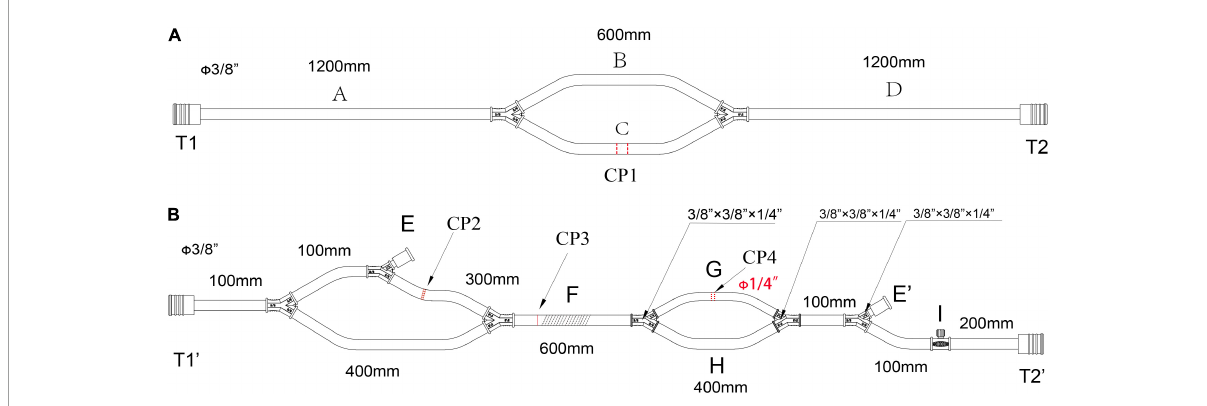
FIGURE1 The main pipelines for cannulation and functional consumables connection in the LHB circuit. (A) The pipelines for cannulation, all diameters of the circuits are 3/8 inch, CP1 is the cut-point for connection of the cannulation of the inferior left pulmonary vein and the aortic cannulation. (B) The functional consumables connection pipelines of the LHB circuit. CP2 is the cut-point for the connection of a hard-shell reservoir, CP3 is the cut-point for a centrifugal pump, and CP4 for the heat exchanger. Line F can be occluded by a roller pump rather than a centrifugal pump in CP3. The port E and port E’ are a pair for an ultrafilter. Port I with a side hole is connected with a T-type adapter, which can be connected to a pressure monitor, and an arterial sampling connector. Both the port T1 in panel (A) and the port T1’ in panel (B) are connected with an oxygen saturation monitor or a connector. The port T2 in panel (A) and the port T2’ in panel (B) were connected with a Y-type connector ( ϕ 3/8” x3/8” x1/4”), and the 1/4-inch port of the connector is linked to the line for the selective visceral